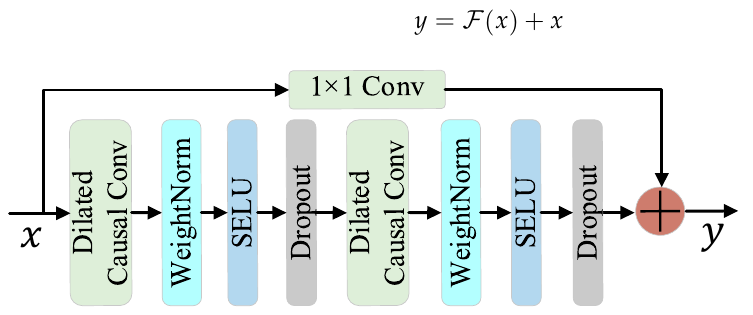
Figure 3. The structure of the residual block.